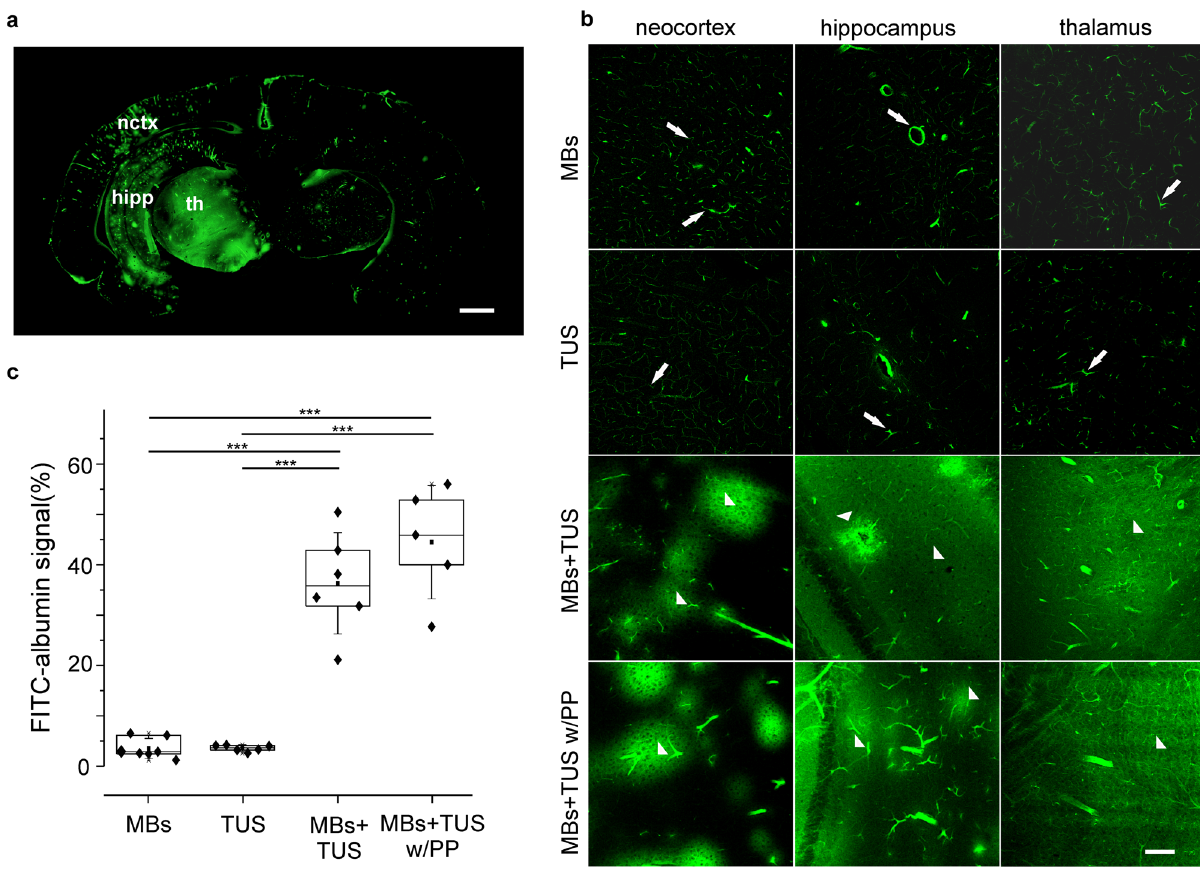
Figure 3. Polyolefin plate interposition consents MBs + TUS induced BBB-opening. ( a ) Representative photomicrographs of a coronal brain section showing the intra-parenchymal FITC–albumin signal following TUS stimulation performed on the left hemisphere during MBs infusion. The somatosensory neocortex (nctx), the hippocampus (hipp) and the thalamus (th) of the left hemisphere were treated with TUS stimulation. ( b ) High resolution confocal microscope photomicrographs of FITC–albumin signal in neocortex, hippocampus and thalamus in control conditions (MBs or TUS only first and second rows, respectively) and after the application of the MBs + TUS, with (bottom row) or without (third row from the top) the interposed polyolefin plate (PP). Under control conditions, no BBB damage occurred. Brain sections showed exclusively intraluminal signal with scattered perivascular spots (white arrows). Areas of a wide FITC–albumin parenchymal extravasation around vessels (white arrowheads) were detected after the application of MBs + TUS with or without the polyolefin plate . Calibration bar = 100 µm. ( c ) Quantification of FITC–albumin leakage in the four experimental conditions reported in the “Methods” section. FITC-albumin signal was quantified measuring fluorescence density, expressed as area occupied by the FITC-albumin. ANOVA followed by post hoc Tukey’s test was performed to compare the measurements obtained in the four experimental conditions, ***p ≤